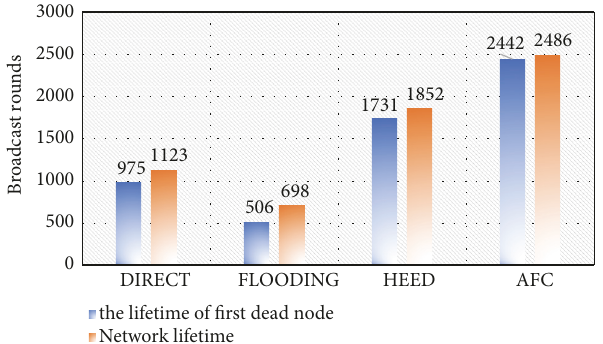
Figure 8: The number of broadcast rounds regarding the lifetime of first dead nodes and that of the network